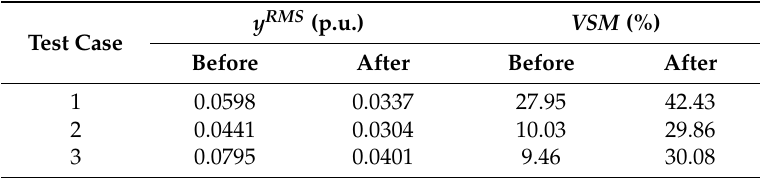
Table 1. Summary of the results for IEEE 9-bus. VSM , Voltage Stability Margin.